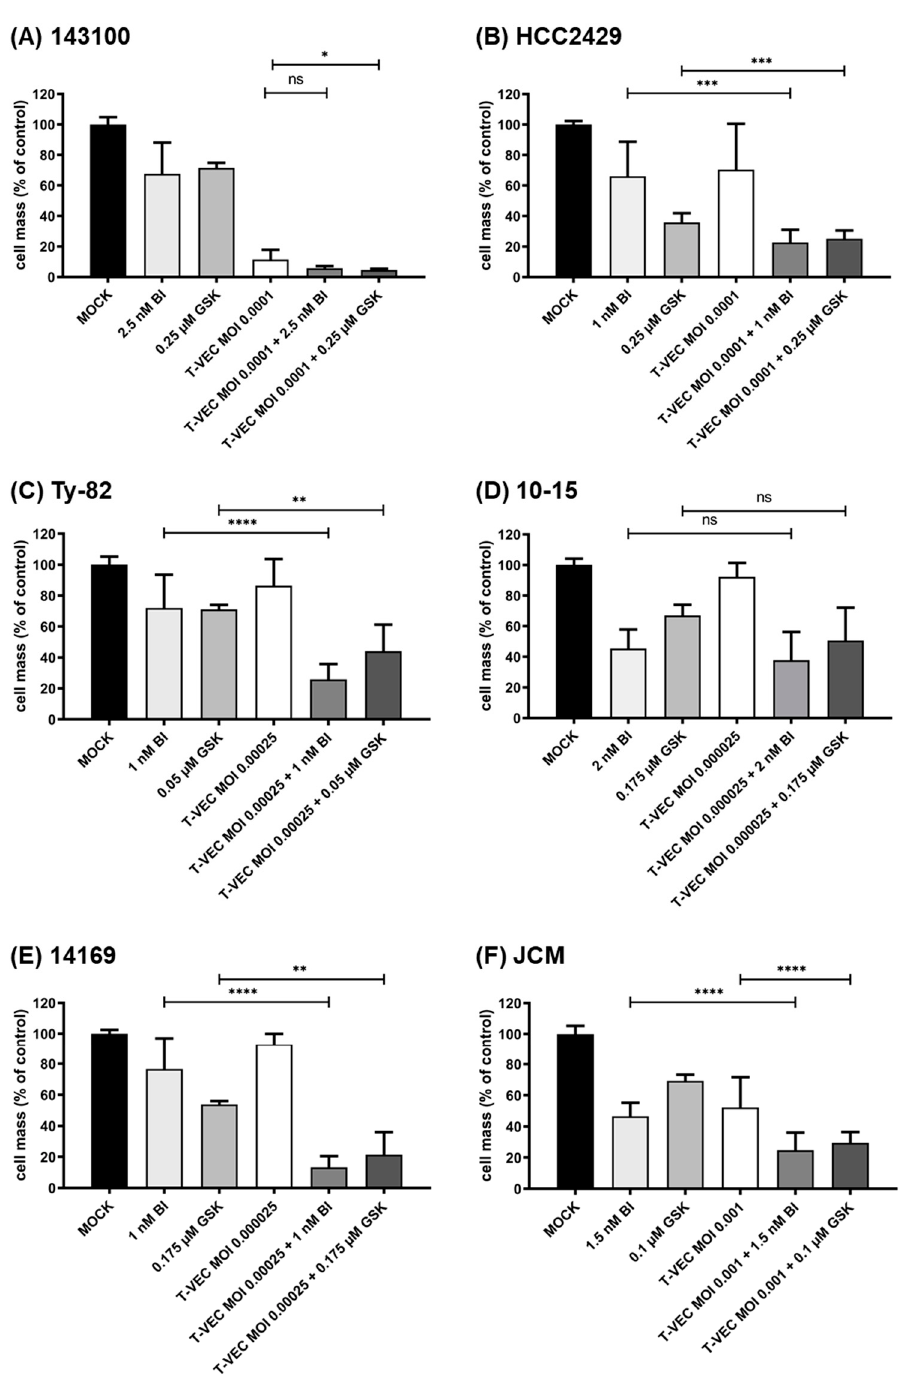
Figure 4. Viability of human NC cell lines after combinatorial treatment with T-VEC and either BET inhibitor (iBET) BI894999 (BI) or GSK525762 (GSK): 143100 ( A ), HCC2429 ( B ), Ty-82 ( C ), 10-15 ( D ),